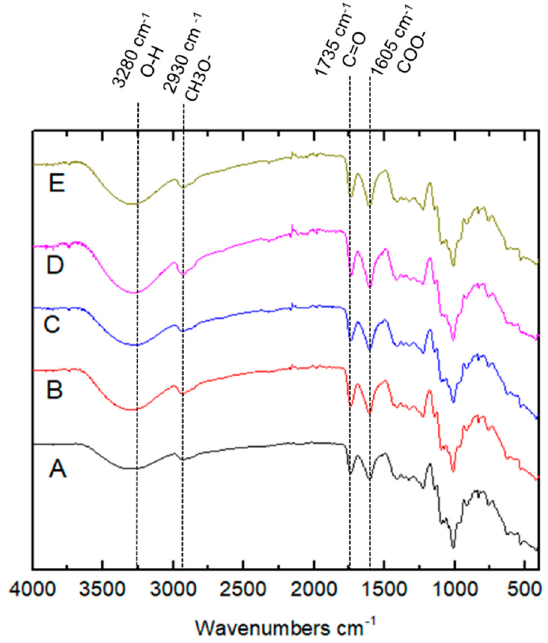
Figure 4. Fourier transform infrared (FTIR) spectrum of films. (A) Control, (B) Copena F1 without fibre (Copwtf), (C) Copena F1 with fibre (Copwf), (D) Villanueva without fibre (Viwtf) and (E) Villanueva with fibre (Viwf).